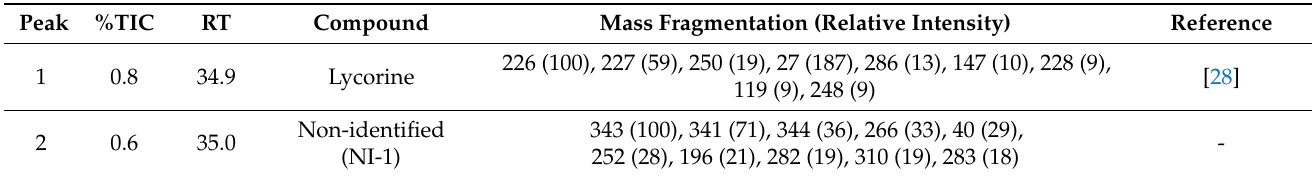
Table 1. Metabolites of Hippeastrum stapfianum identified by gas chromatography–mass spectrometry